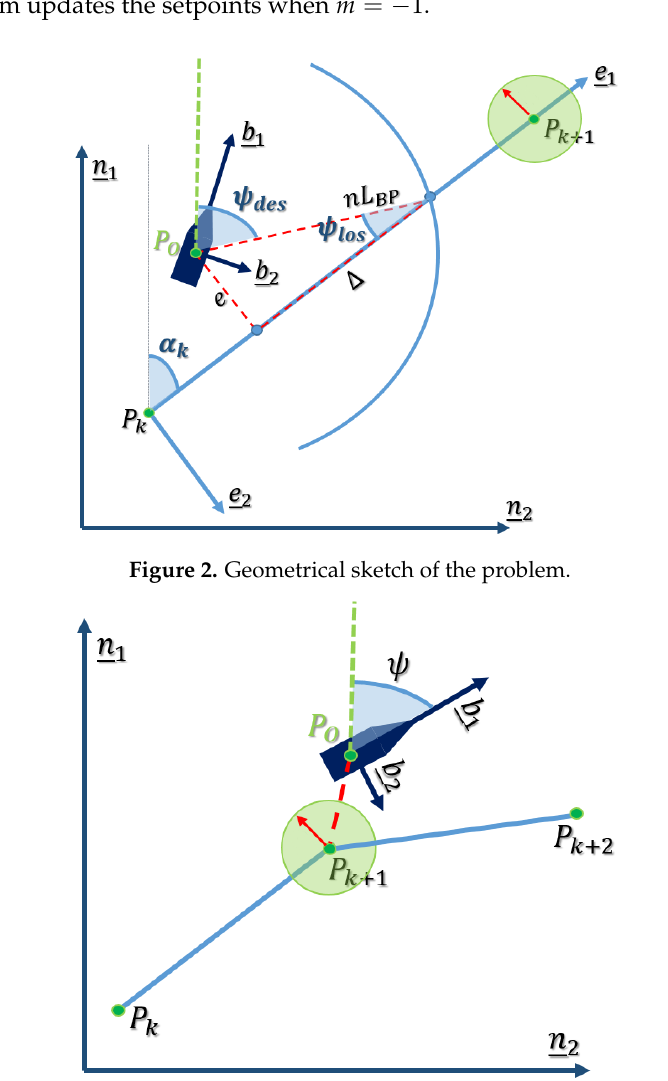
Figure 3. Bypass in case of a missed